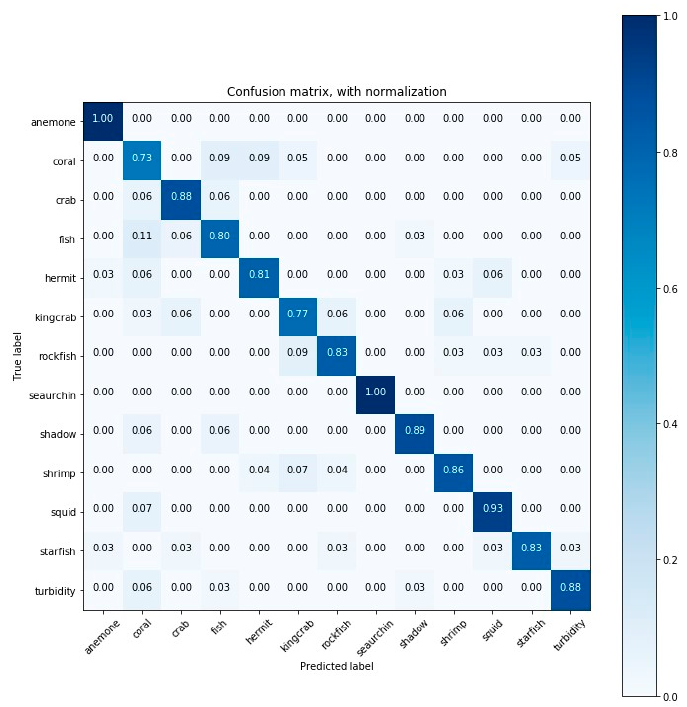
Figure A11. Confusion matrix for the classification results (accuracy) obtained by CNN-4.